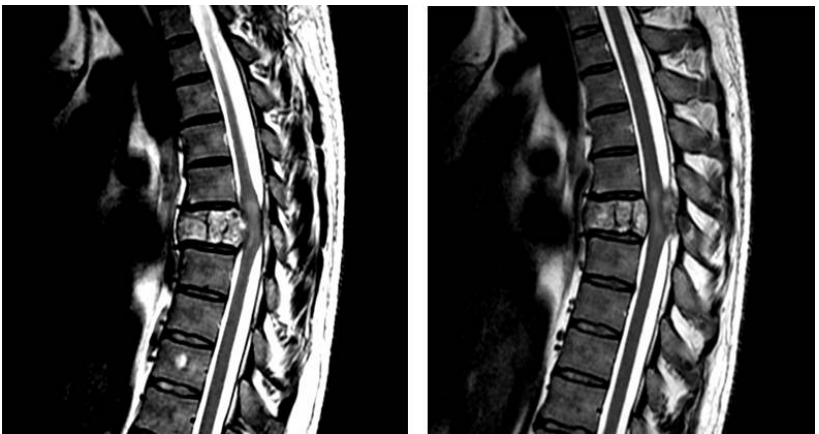
Figure 1. Spinal Cord Injury visualized on MRI-T2 sequence.